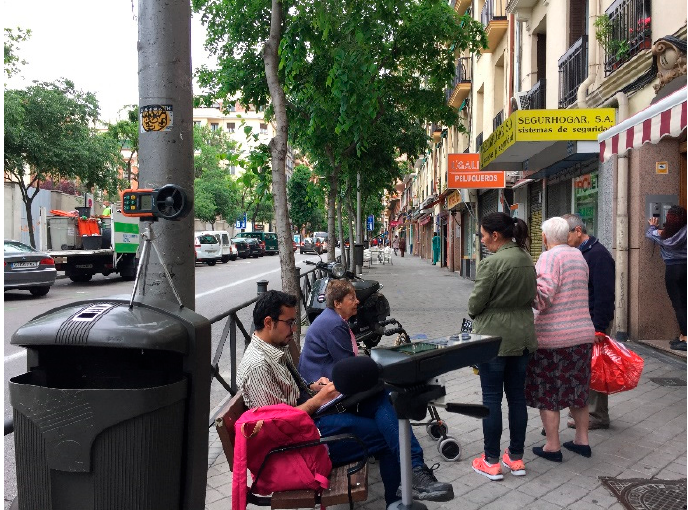
Figure 4. Measurement and survey at point 2 in CVH Street, Madrid.